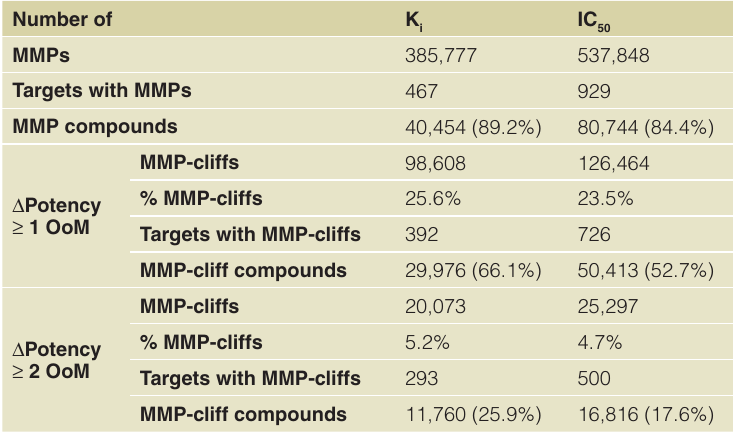
Table 2. MMP and MMP-cliff